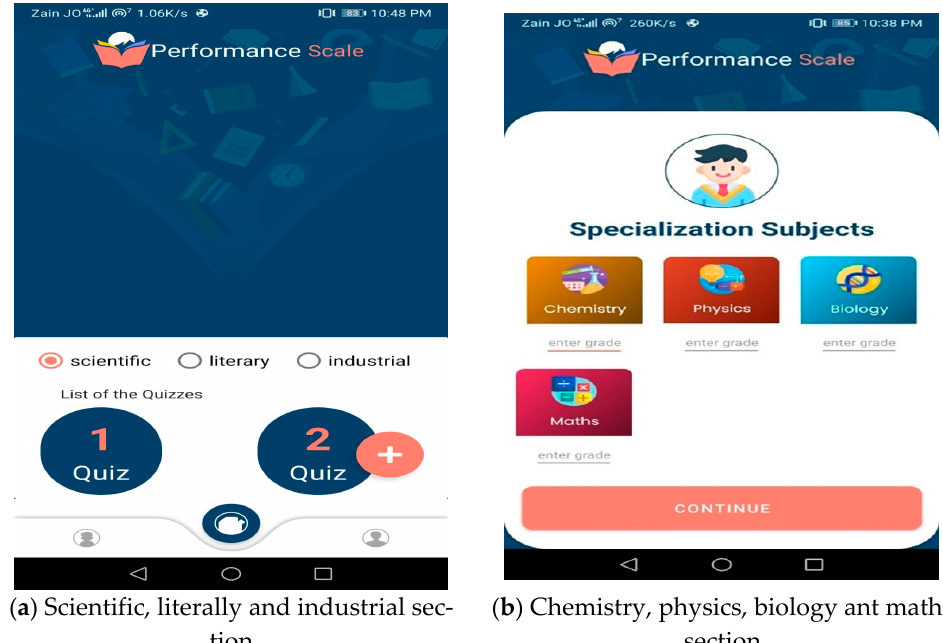
Figure 6. Specialization screen.